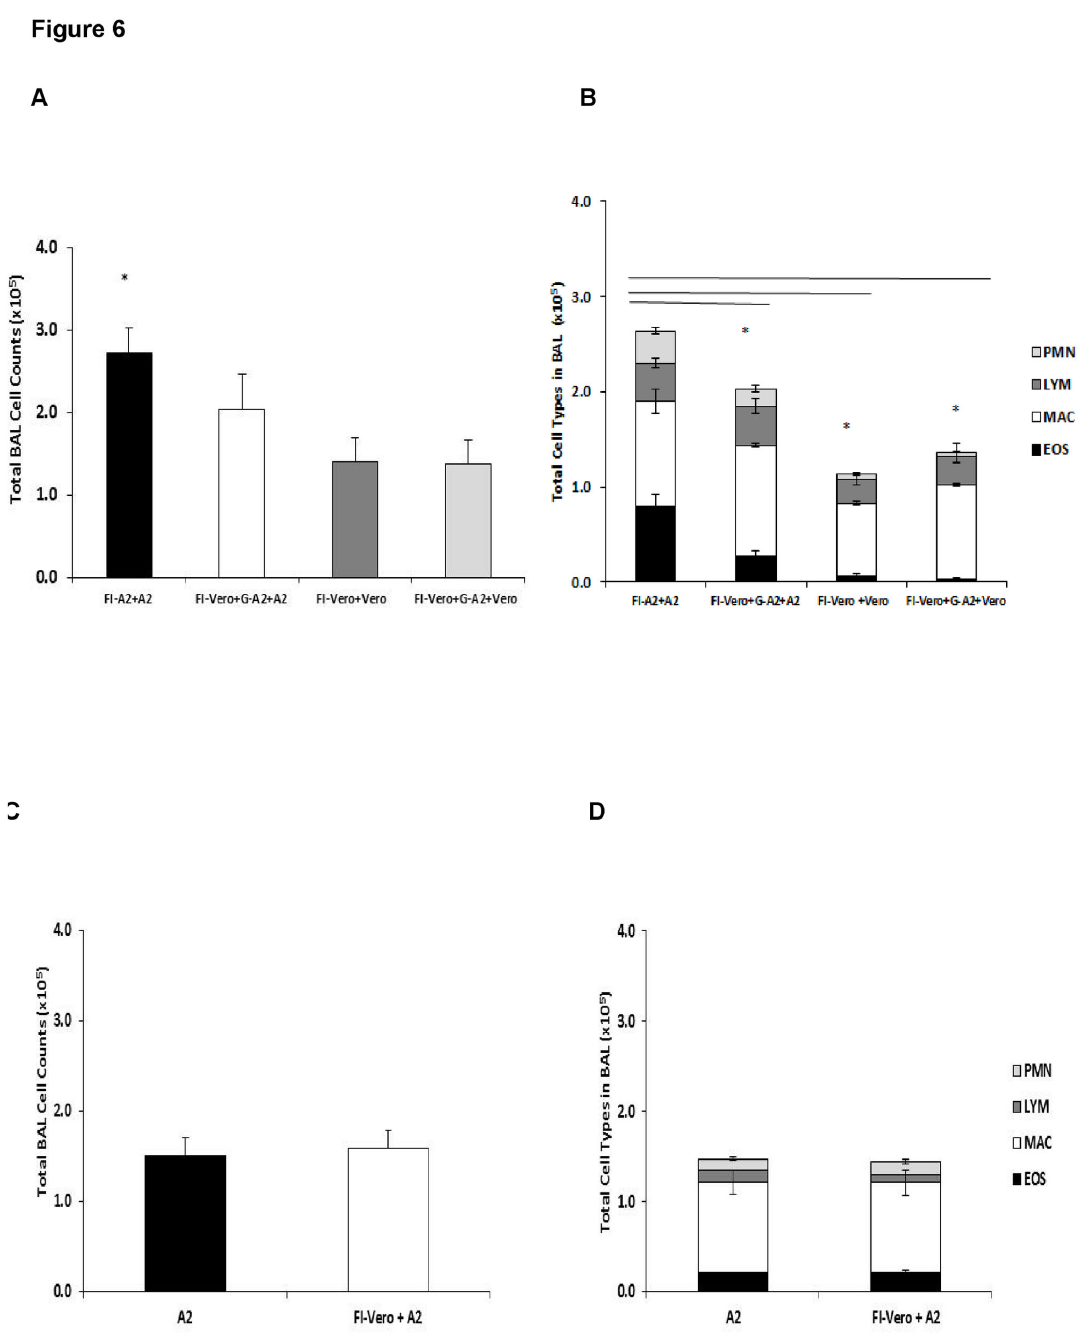
Figure 6. Pulmonary cell infiltration following FI-RSV and FI-Vero vaccination. (A) Total BAL cell counts in the lungs of mice i.m. vaccinated with FI-RSV A2 and live RSV A2 challenged (FI-A2+A2), mice vaccinated with FI-Vero cell lysate supernatant and then challenged with Vero cell lysate supernatant (FI-Vero+Vero), or mice vaccinated with FI-Vero lysate and G-A2 peptide and challenged with either RSV A2 (FI-Vero+G-A2+A2) or uninfected, Vero lysate (FI-Vero+G-A2+Vero) (day 5 post-infection). (B) Total neutrophils (PMN), lymphocytes, (LYM), macrophages (MAC) and eosinophils (EOS) counts in BAL. (C) Total BAL cell counts in the lungs of mice vaccinated with or without FI-Vero supernatant at day 5 post-RSV A2 challenge. (D) Total PMN, LYM, MAC and EOS counts in the BAL of mice infected with A2 and mice vaccinated with FI-Vero cell lysate and then challenged with RSV A2 (FI-Vero +A2) at day 5 post-challenge are shown. Significance was calculated using a Student's t test, comparing mice in each group to mice vaccinated with FI-A2 alone and challenged with RSV. * p<0 . 05 . doi: 10.1371/journal.pone.0083075.g006 PLOS ONE |